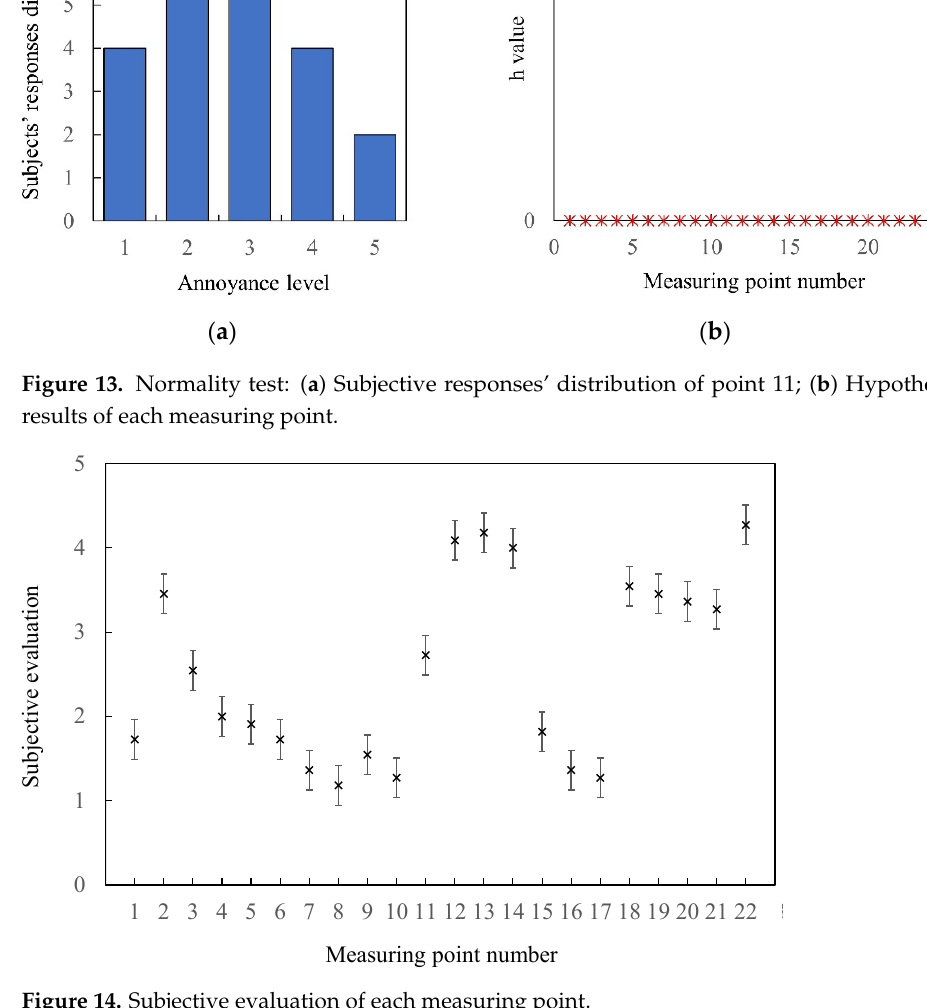
( b ) Figure 15. Training progress of the binaural MFCC-CNN model: ( a ) Training accuracy; ( b ) Training loss.